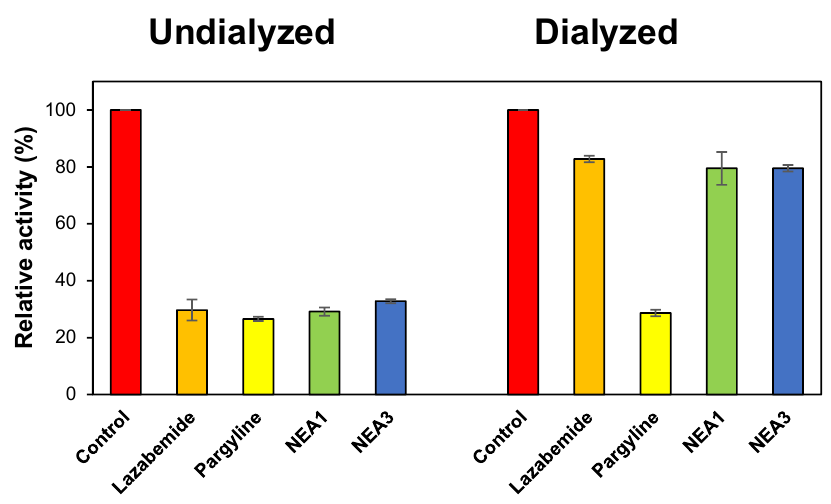
Figure 2. Recoveries of MAO-B inhibitions by NEA1 and NEA3 using dialysis experiments. Dialysis was performed for 6 h with a buffer change after 3 h with duplicate